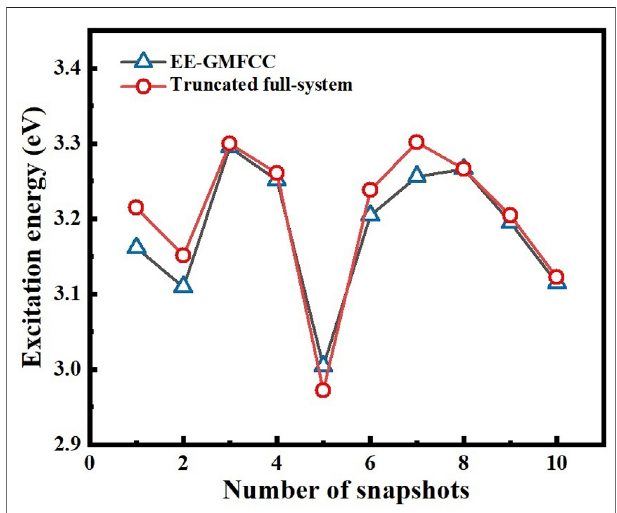
FIGURE 8 | Decomposed excitation energy contributions of some ribonucleotides close to the fl uorophore molecule using the GMFCC method. The results are the average values calculated on 10 snapshots extracted from the100-nsMDsimulationevery10ns.Thecontributionswereconverted into wavelengths and presented by the color between blue and red. Ribonucleotides with positive 2B QM corrections have blue shifts of the absorption spectrum and are colored in blue, while ribonucleotides with negative 2B QM corrections have red shifts and are colored in red. EKJ is the fl uorophore in this RNA system. The wavelength contribution of each ribonucleotide with bold comes from TD-HF/6-31G* calculations, while those without bold come from TD- ω B97X/6-31G* results,